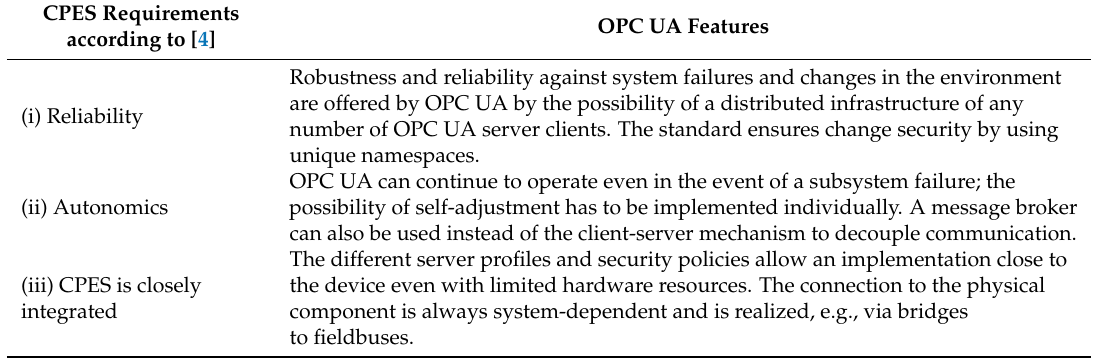
Table 2. Cyber-physical energy systems (CPES) features and their coverage by OPC Unified Architecture (OPC